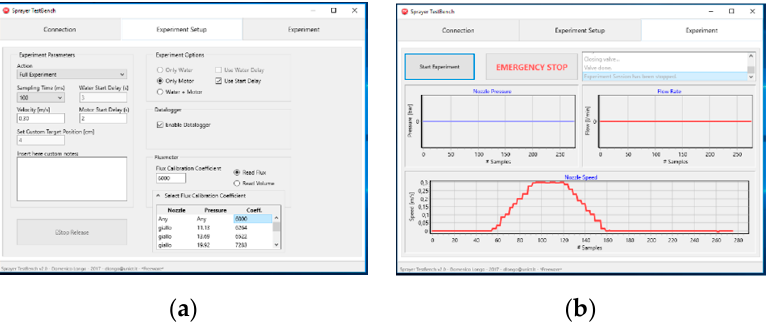
Figure 4. User interface: ( a ) tab used to manage the spray trials and set the working parameters; ( b ) tab used to monitor the sensor signals and to stop the system in case of emergency.